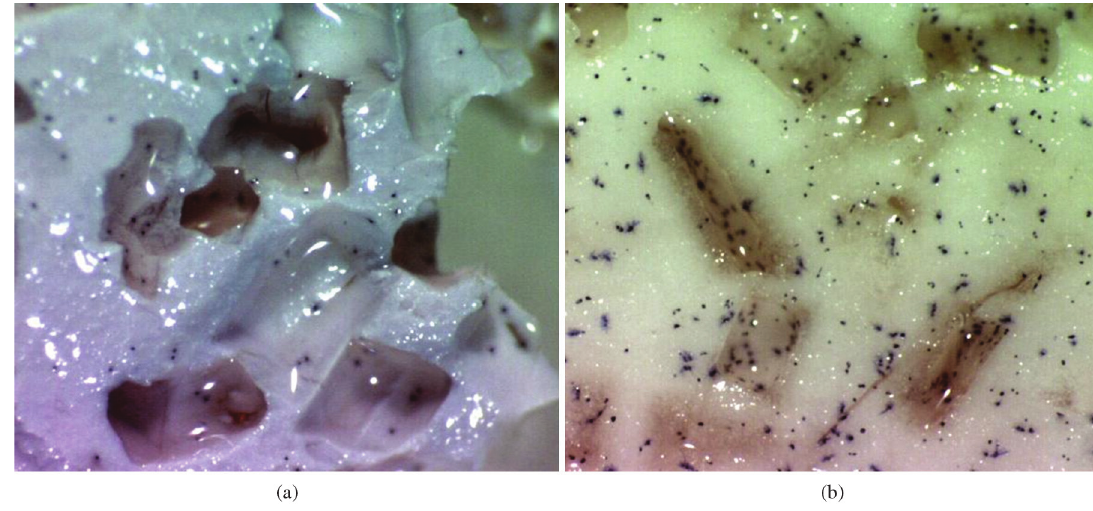
Figure 4. Cells adhered on scaffolds after 2 days. (a) Scaffold A. (b) Scaffold B. Zoom: 20x.